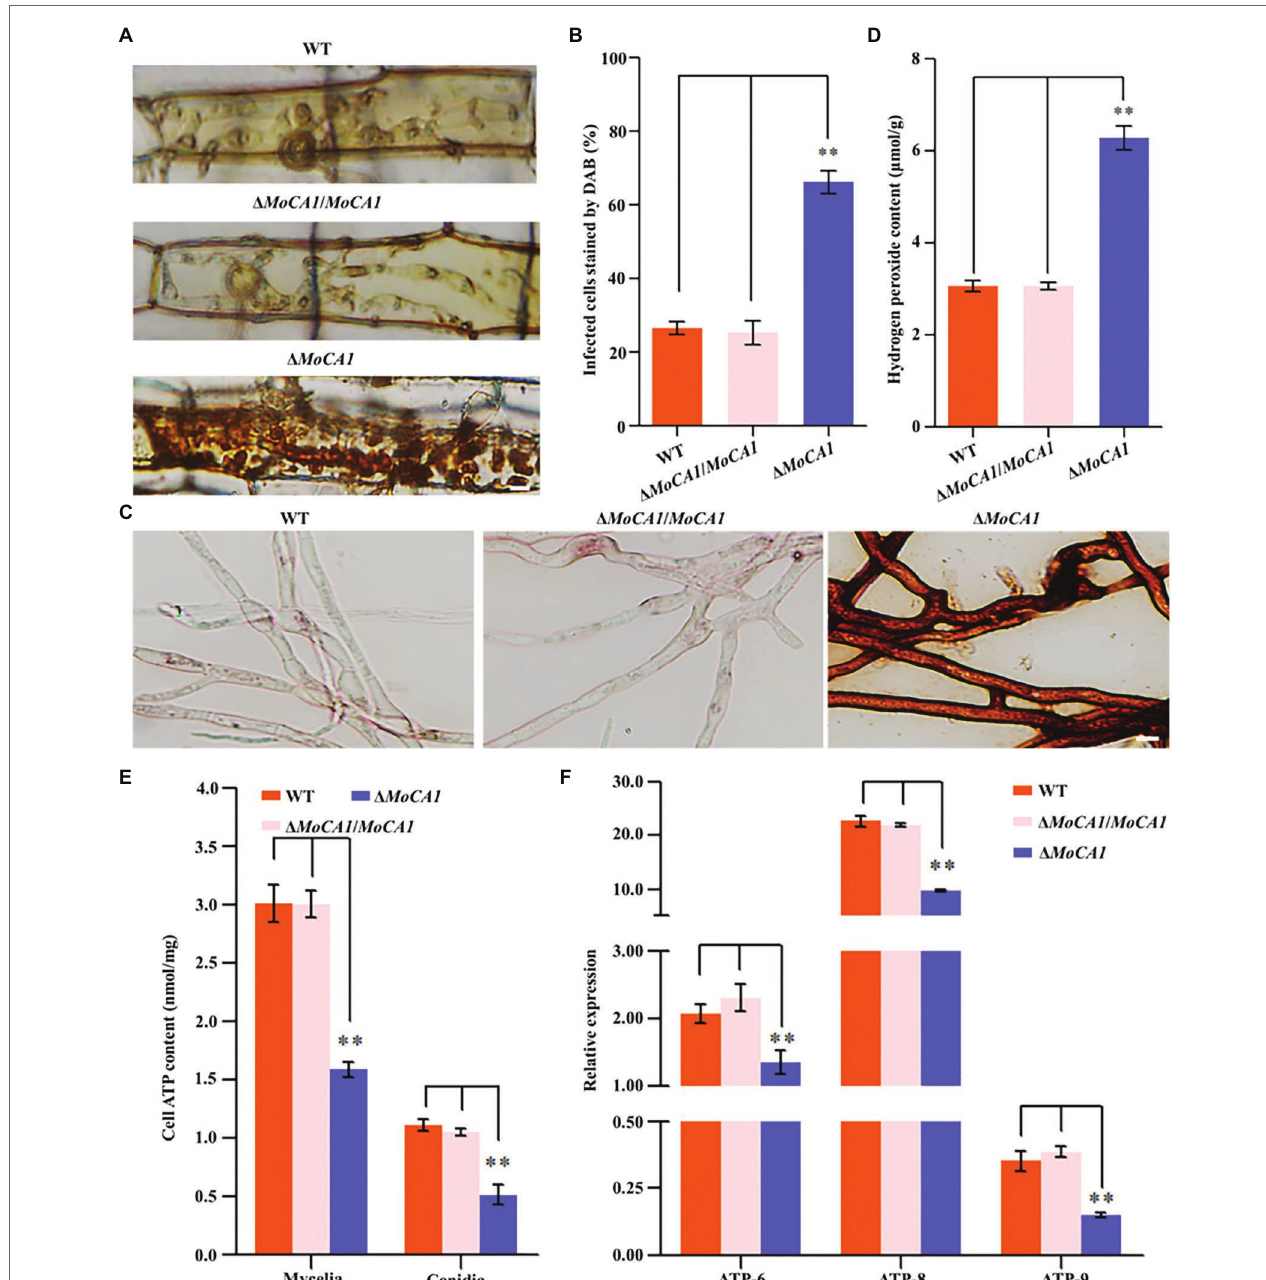
FIGURE 5 | Comparison of 3,3 ′ -diaminobenzidine (DAB) staining and endogenous H 2 O 2 among the strains. (A) DAB staining of leaf sheath cells of rice infected by wild-type, mutant, and complementation strains at 36 hpi. Scale bar = 10 μ m. (B) Statistical analysis of DAB staining of leaf sheath cells infected by different strains. (C) DAB staining of hyphae of the wild-type, mutant, and complementation strains. Scale bar = 10 μ m. (D) Endogenous H 2 O 2 assay. The strains of hyphae of endogenous H 2 O 2 were determined as described in experimental methods. (E) Cellular ATP assay. (F) Differential ATP synthesis genes analysis on transcriptomes of the strains. The above experiments were performed in triplicate and repeated three independent times for each strain. Error bars represent the ±SD of three independently repeated samples, ** p <